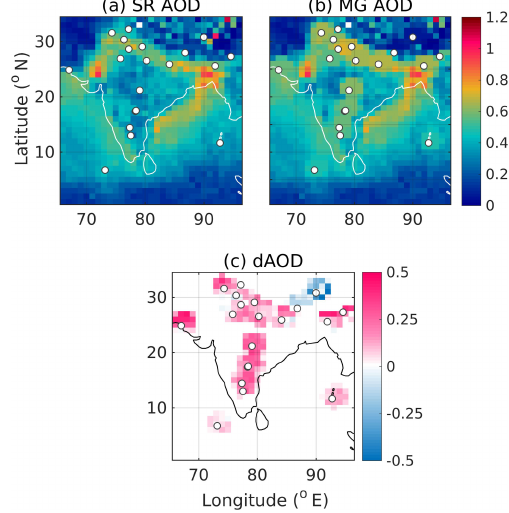
Figure 7. Spatial variation of monthly mean SR AOD (a) , MG AOD (b) and dAOD (c) for May 2009.